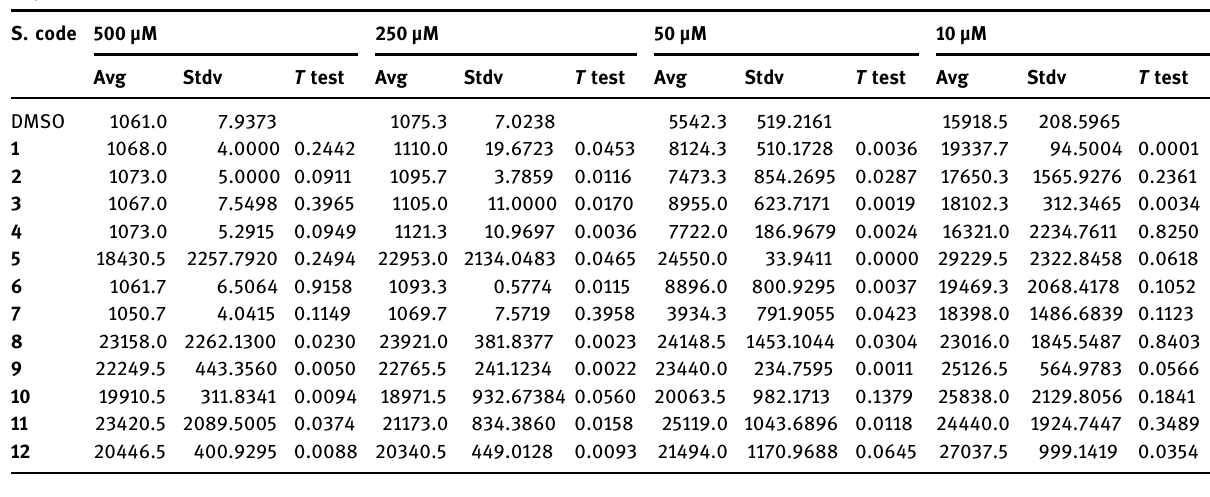
Table 3: Proliferation data for day